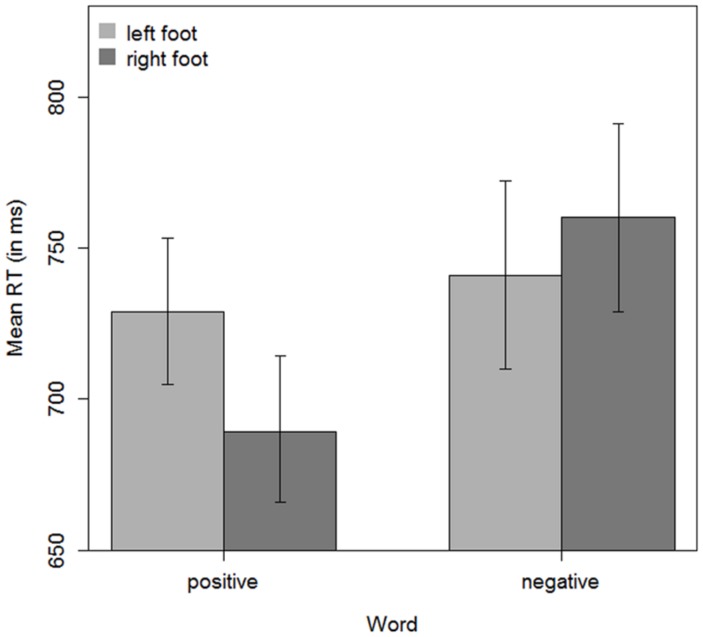
Mean response times for all participants (n = 37) for responses to positive and negative words with the right foot or with the left foot. The error bars represent confidence intervals for within-subject designs and were computed as recommended by Masson and Loftus (2003).